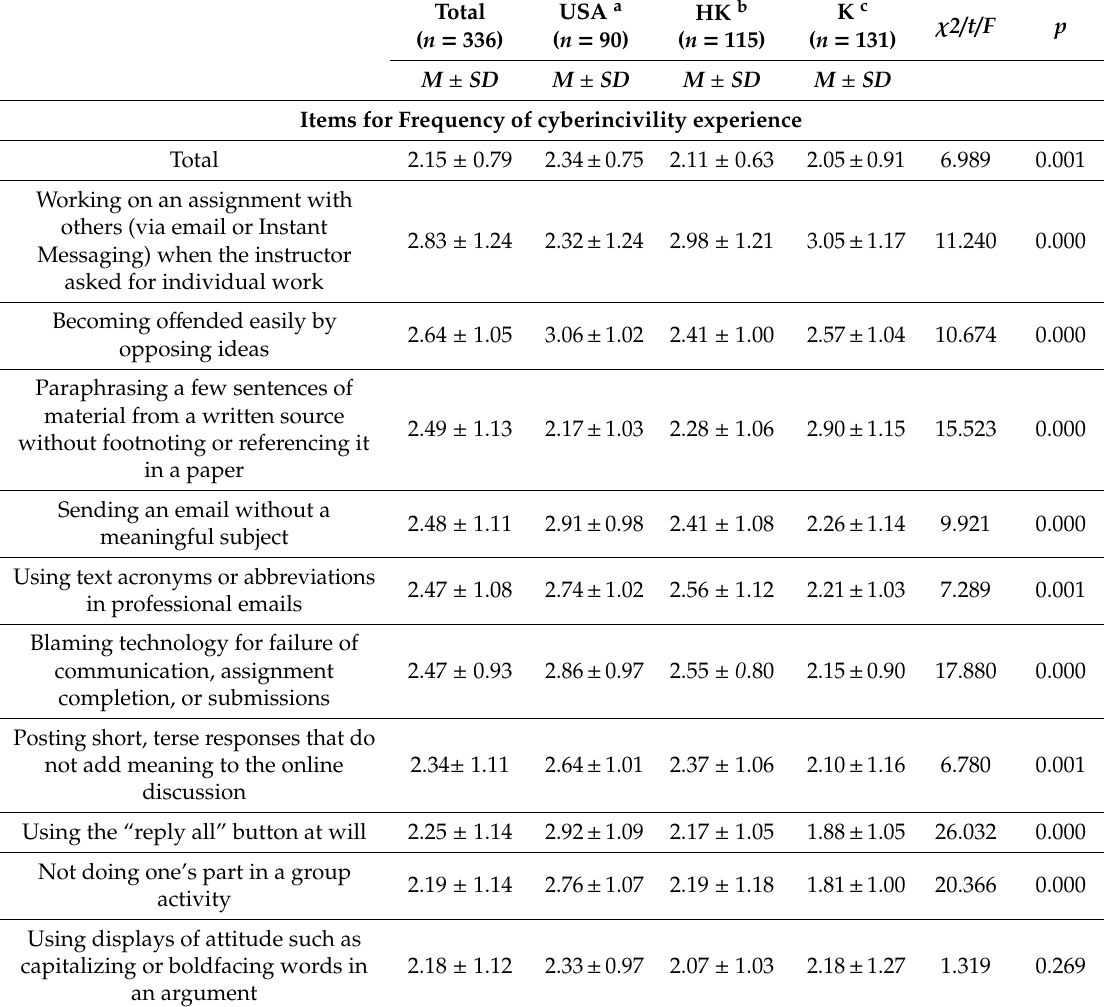
Table 3. Top 10 frequency of experience with, and acceptability of,